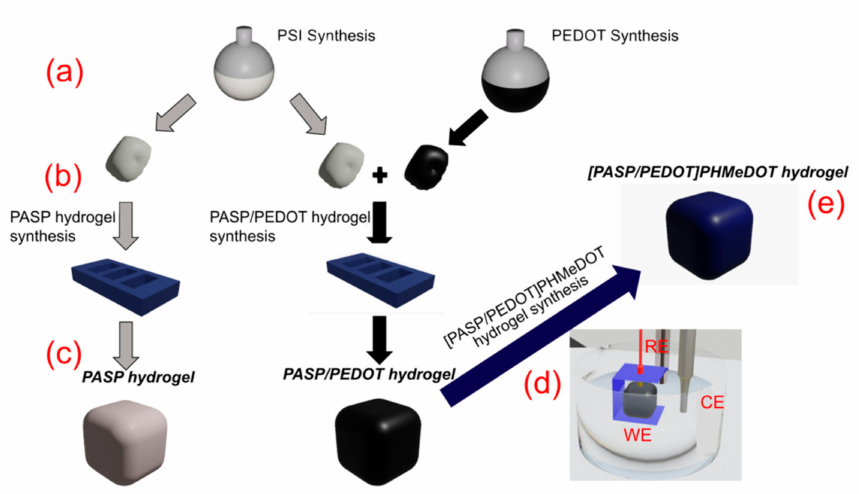
Figure 1. Scheme showing the steps used to produce [PASP/PEDOT]PHMeDOT hydrogels: ( a ) syn- thesis of poly(succinimide) (PSI) and PEDOT particles; ( b ) the PSI was placed in a mold with and without the addition of PEDOT particles to cross-link and form the different hydrogels; ( c ) PASP and PASP/PEDOT hydrogels were obtained after the gelation stage; ( d ) PASP/PEDOT hydrogel was placed in a HMeDOT solution in order to form a PHMeDOT network by electropolymerization; ( e ) [PASP/PEDOT]PHMeDOT CPHs were